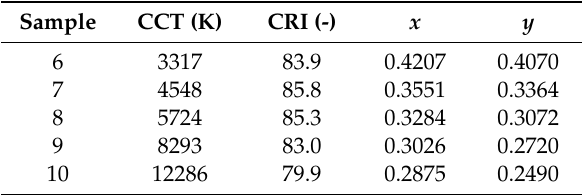
Figure 7. Measured CRI ( a ) and CCT ( b ) values for samples 6–10. Table 3. CCT and CRI values and color coordinates for samples